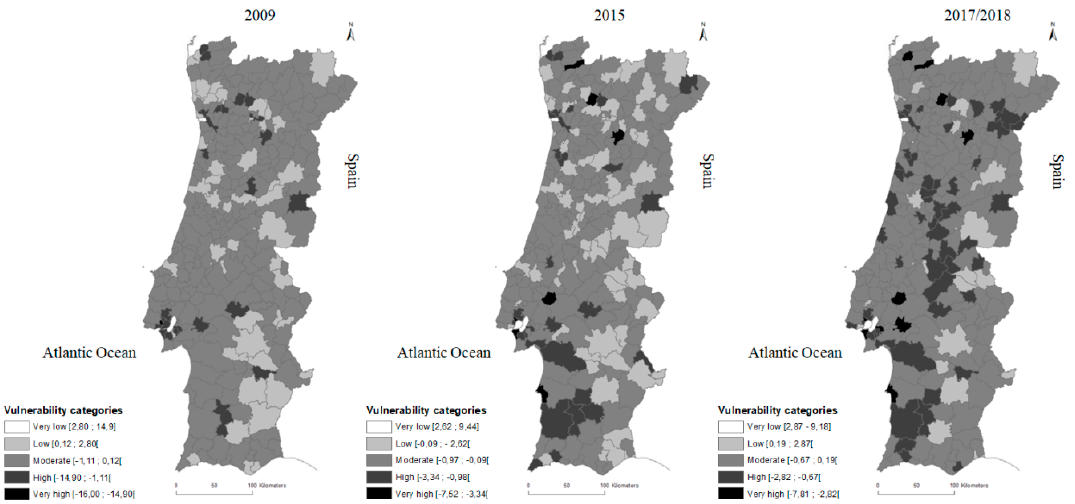
Figure 3. SEHVI cartographic representation for three years under analysis.